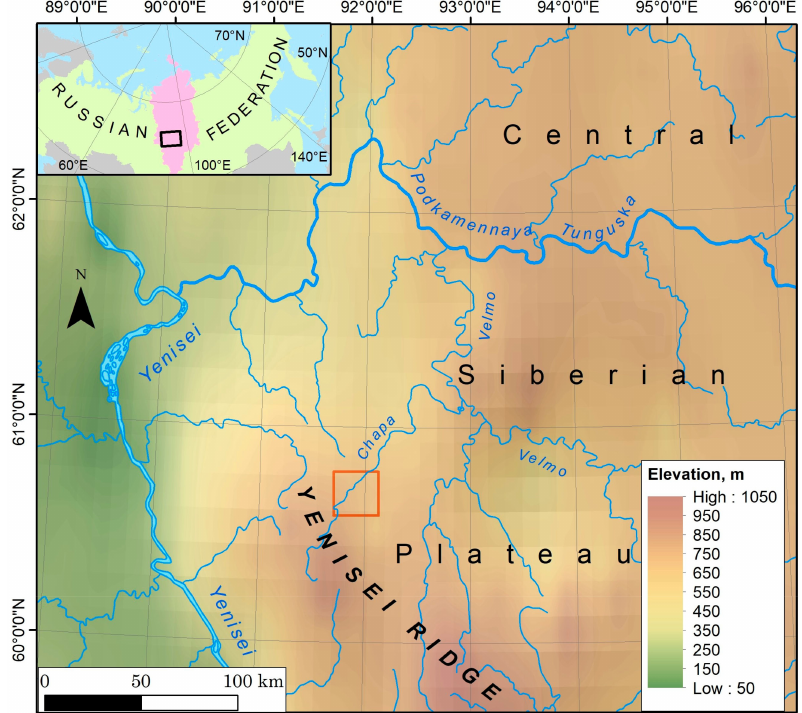
Figure 1. Geographical location of the study area. The red rectangle corresponds to the area of study in the north of the Yenisei Ridge. The pink area in the upper left corner of the map shows the location of the Krasnoyarsk Krai on the Eurasian